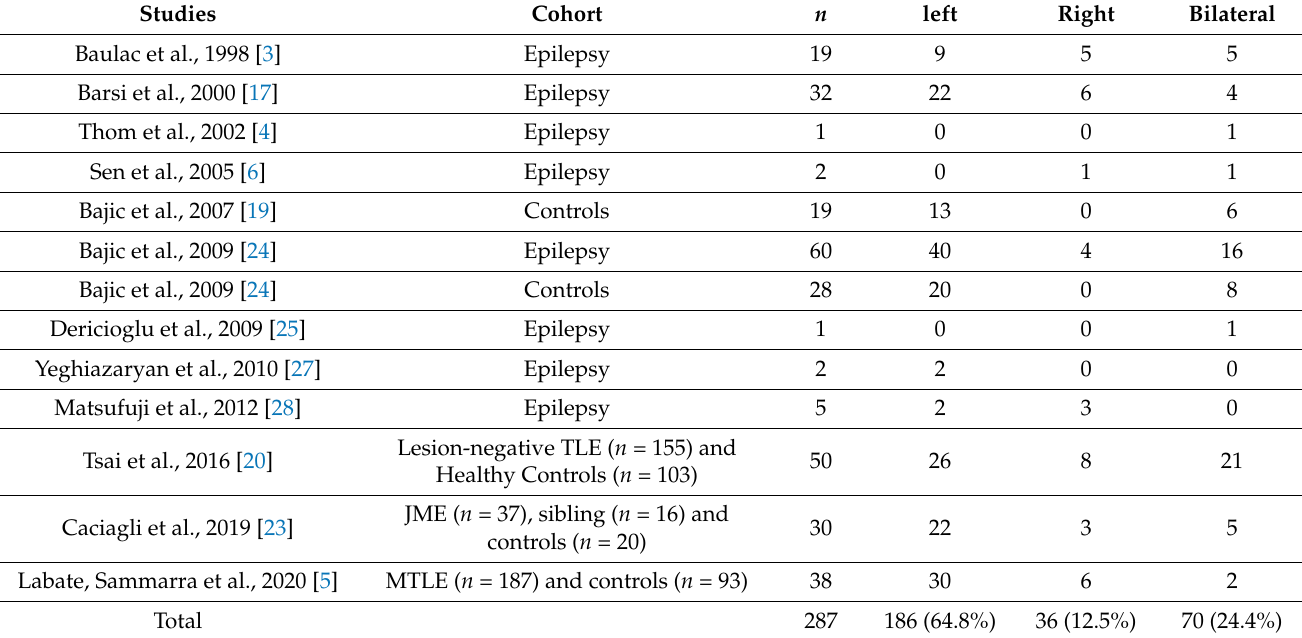
Table 1. Laterality of HIMAL in reported